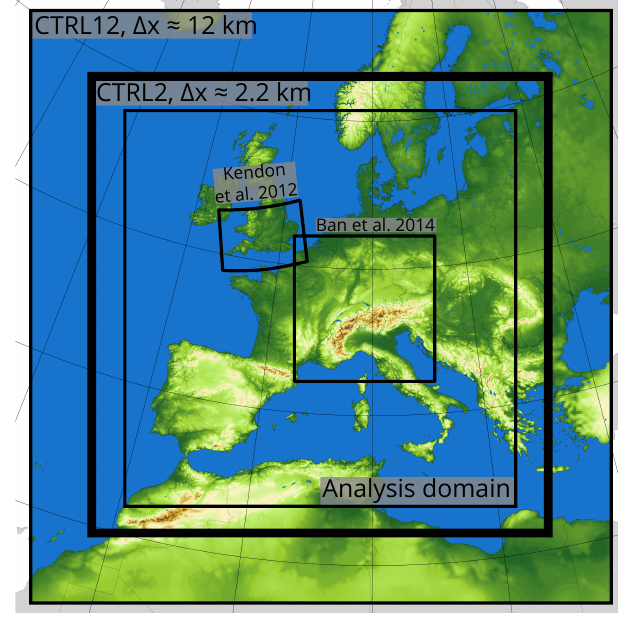
Figure 2. Integration domains and model topography. The outer- most black box shows the domain of the convection-parameterizing simulation with grid spacing of 12km, and the bolder inner box that of the convection-resolving simulation with 2.2km grid spac- ing. The sub-domain used in the analysis is indicated. The two smaller black boxes indicate the domains used in two state-of-the- art convection-resolving climate simulations over the southern UK and the Greater Alpine